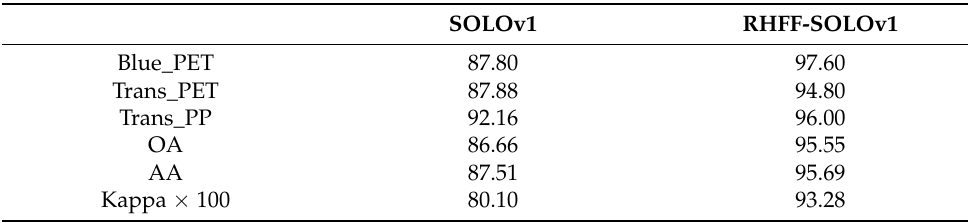
Table 3. The classification results of SOLOv1 and RHFF-SOLOv1.